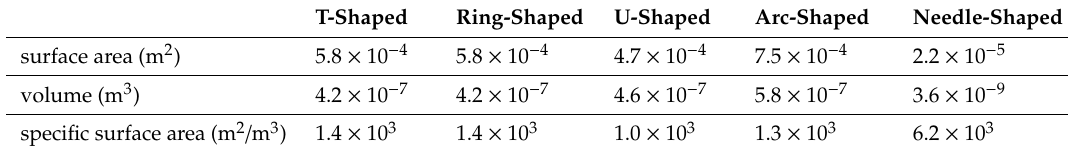
Figure 11. Appearance and dissolution behavior of implants loaded with ( a ) diclofenac sodium (DS) and ( b ) ibuprofen. Table 1. The specific surface area of various implants.